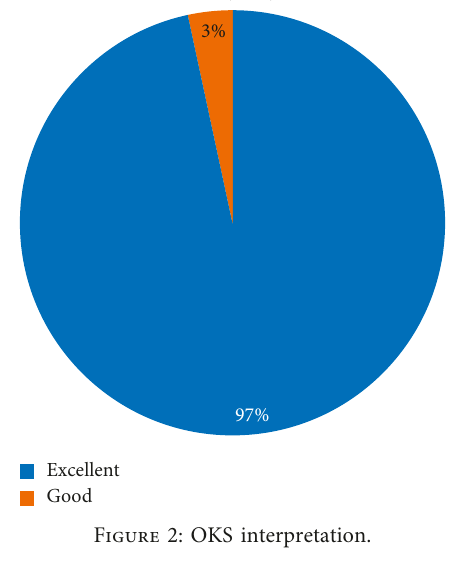
Figure 2: OKS interpretation.